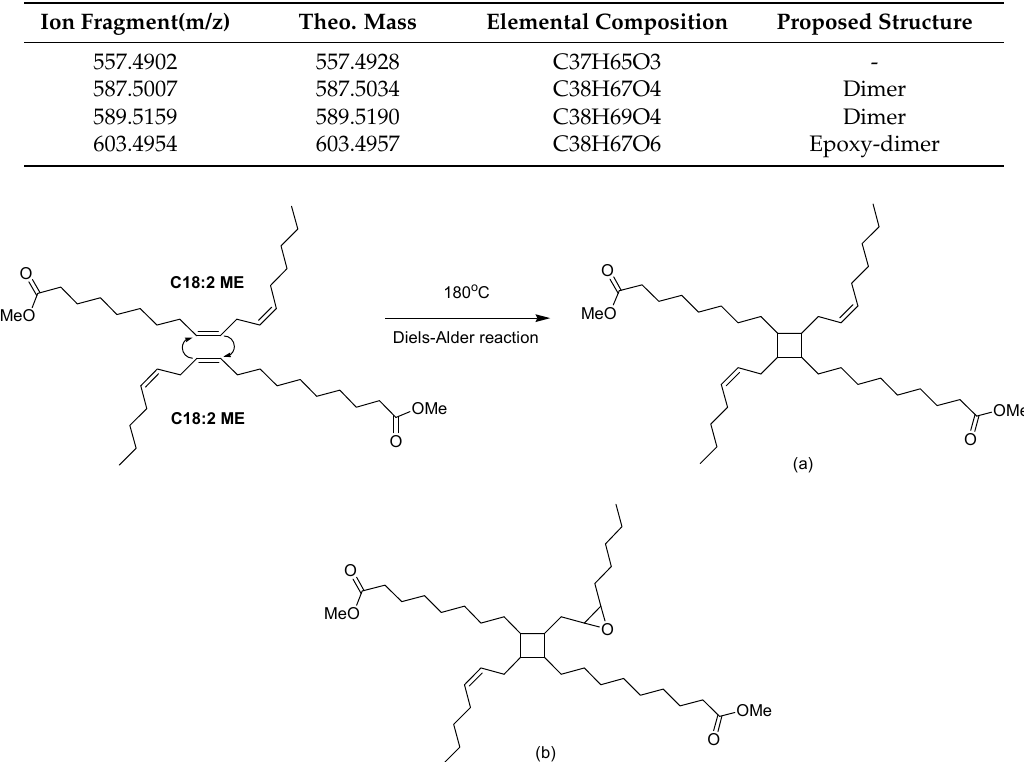
Figure 8. Diels-Alder reaction from C18:2 ME: ( a ) dimer of linoleic acid (C18:2) methyl ester; ( b ) epoxy-dimer of linoleic acid (C18:2) methyl ester.